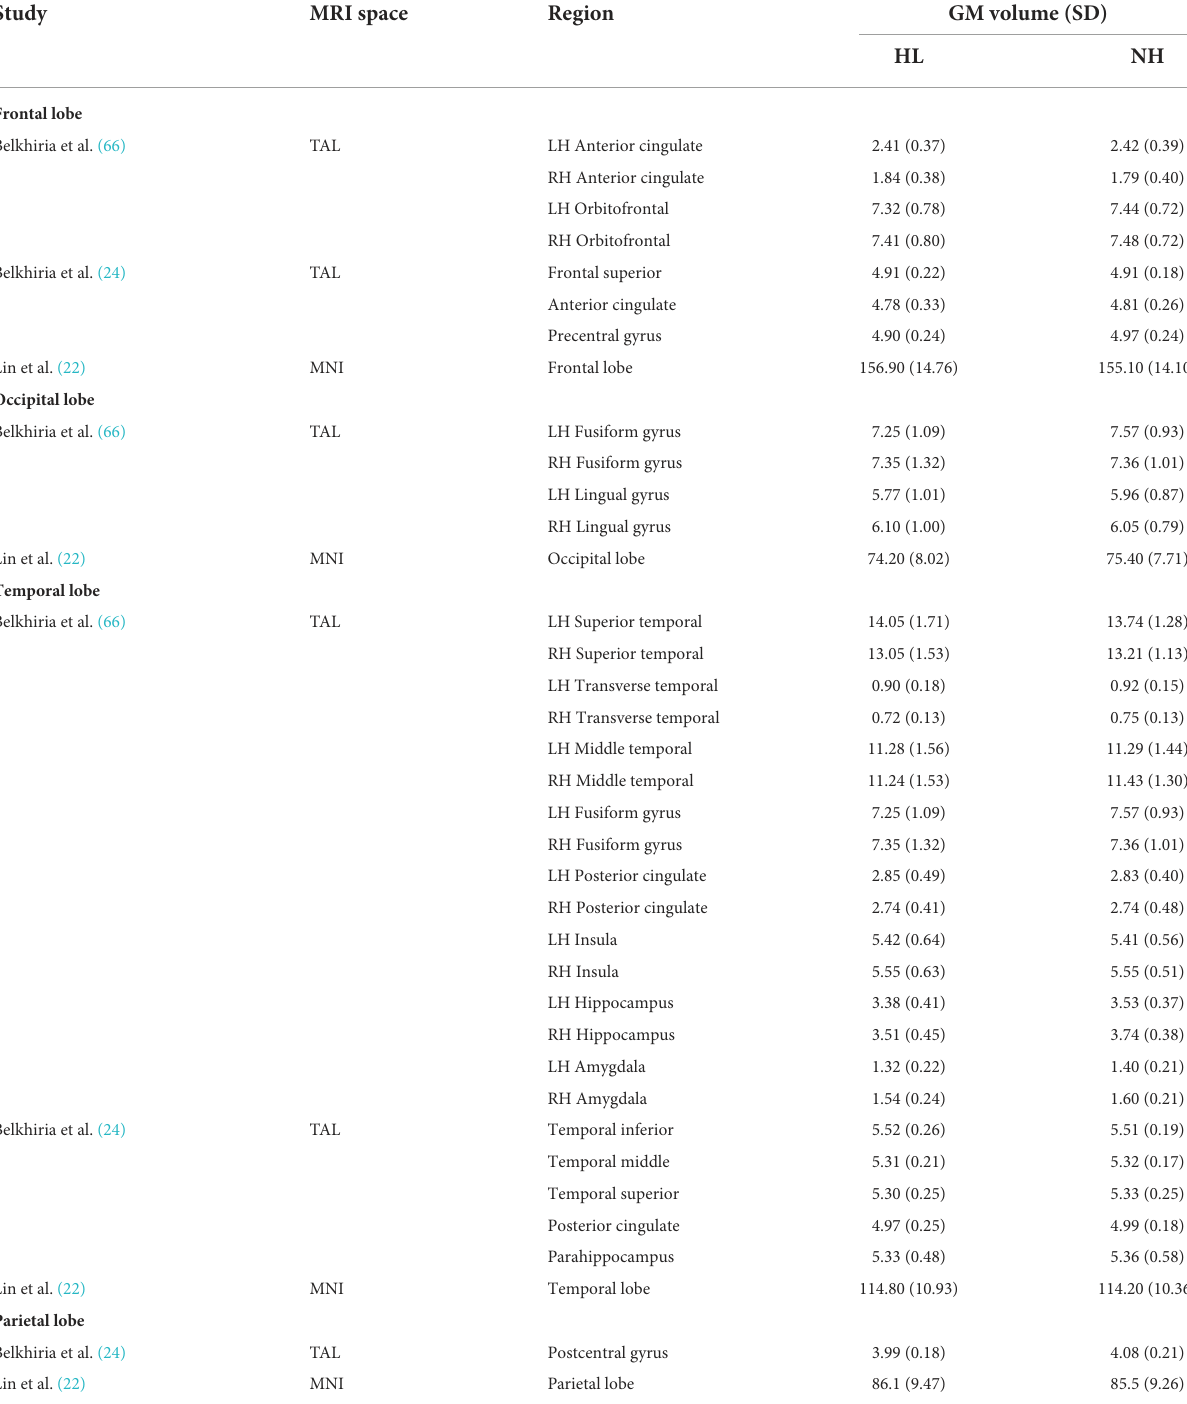
TABLE 6 Available means and standard deviations extracted for meta-analysis of lobe-wise